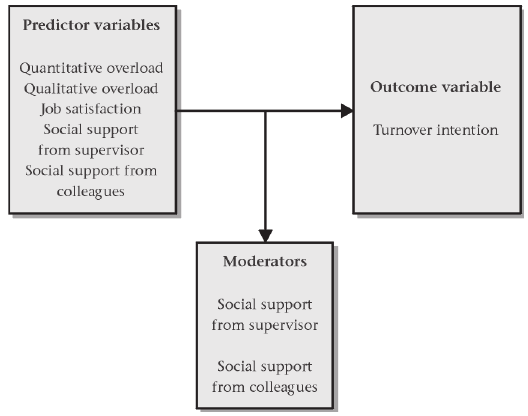
figure 1: The hypothesised